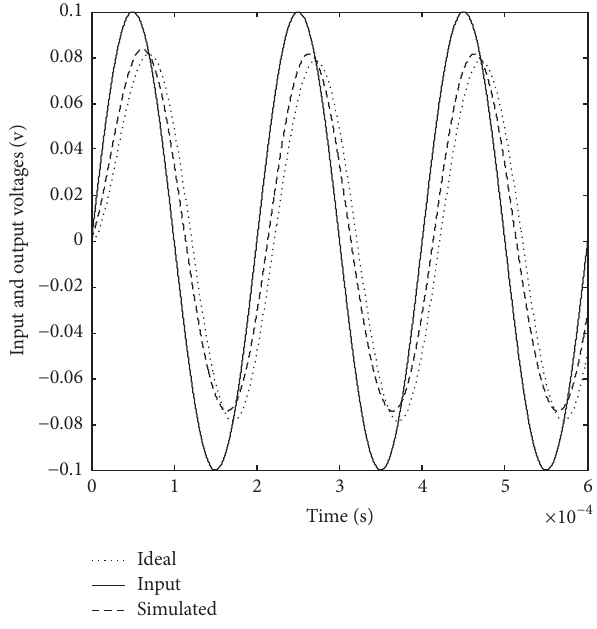
Figure 6: Simulation for the transient